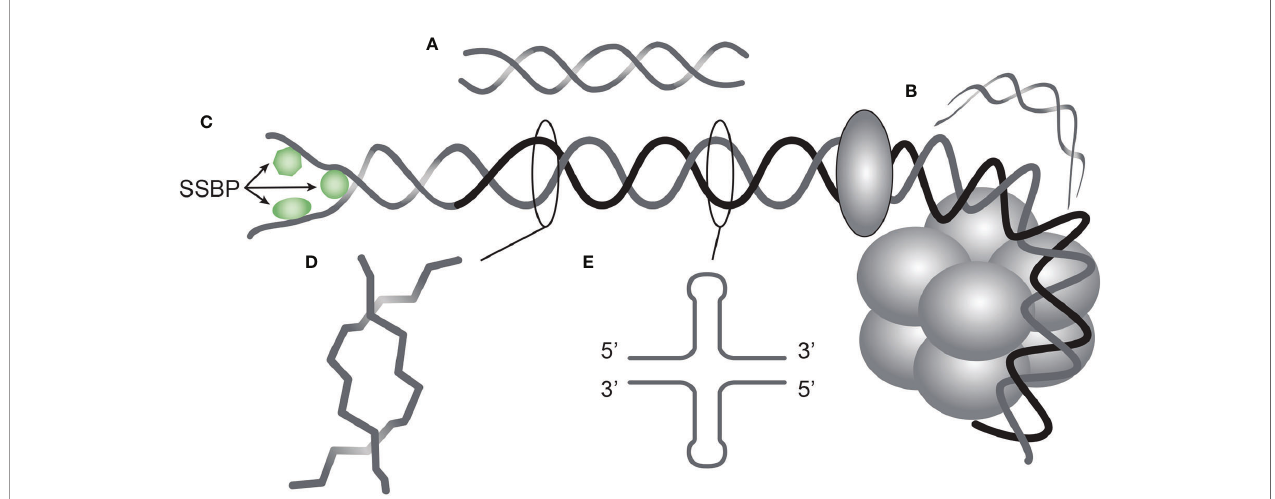
FIGURE 1 | DNA structures in chromatin express distinct DNA functions, and each structure is a unique antigen. Elongated (linker) DNA is a relaxed, right-handed. low-energy linear form of B DNA (A) , while compacted B DNA as in plasmids (not shown) and in core nucleosomes are de fi ned as bent B DNA (B) . In (C) the B DNA helix is opened by single-DNA binding proteins (i.e. proteins stabilizing ssDNA and polymerizes involved in replication and repair). In (D) Z DNA is demonstrated, which is a left-handed, high energy, supercoiled double helix. Physiologically, Z DNA forms during transcription as a result of torsional strain that depend on interaction of mobile polymerases. Z DNA is predominantly associated with linker DNA and regulate transcription. Cruciform DNA is another structure formed in dsDNA (E) , and is different from B and Z DNA. Its generation requires that repeat sequences (palindromes) in one strand is repeated on the other strand in opposite direction. The cruciforms are, like Z DNA, higher energy DNA structures. From an immunogenic point of view, each structure (A – E) is unique in terms of inducing highly speci fi c antibodies with potential pathogenic impact if chromatin is exposed in situ. See text for